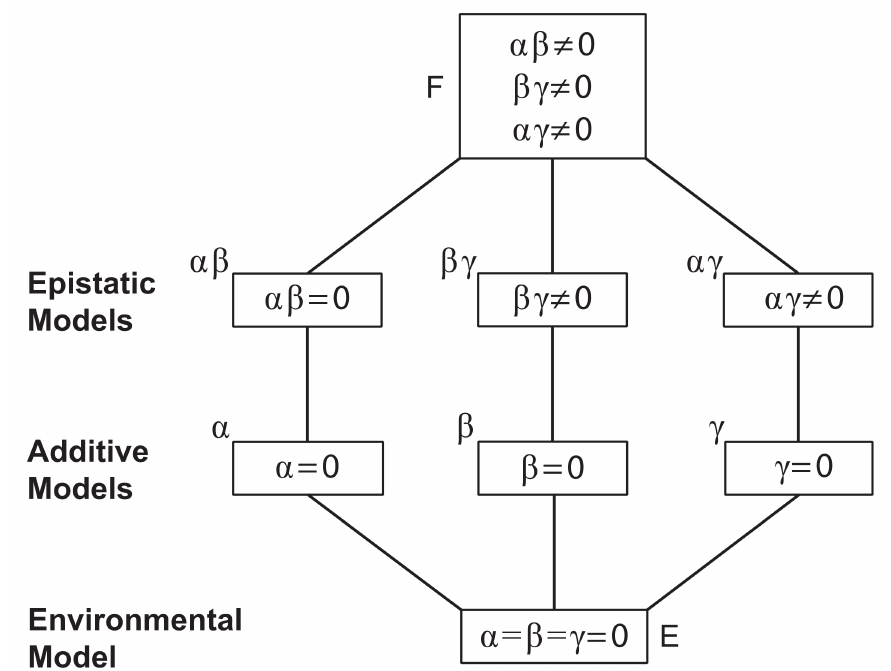
Figure 6. The above hierarchy of models contained particular models that fit the phenotypic counts on three crosses between parents with di ff erent conidiophore phenotypes. At the top of the model hierarchy is the full epistatic model (F) with a grand mean, three additive allelic e ff ects, and three epistatic interactions. At the bottom of the hierarchy is an environmental model with no genetic e ff ects on conidiophore phenotype (E). Intervening models in the hierarchy drop one or more parameters describing the additive and epistatic e ff ects of genes A, B, and C associated with the conidiophore phenotypes, A, B, and C.